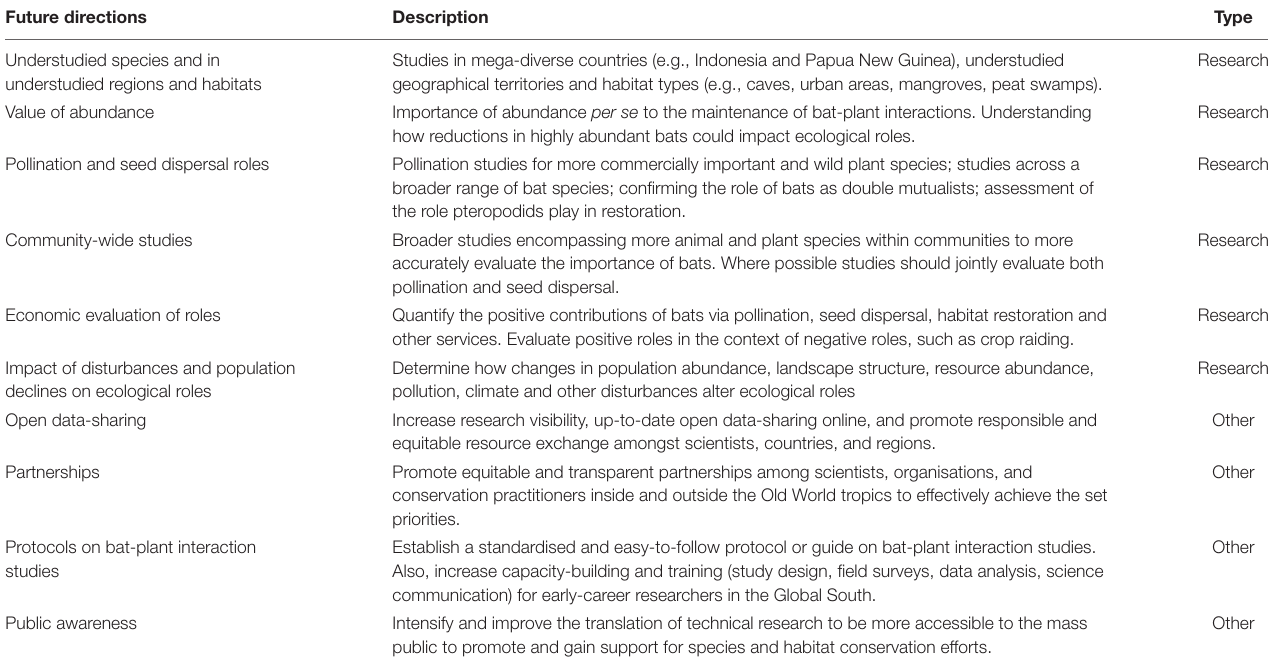
TABLE 6 | Directions for future research directions and other efforts to bolster progress on understanding pteropodid-plant